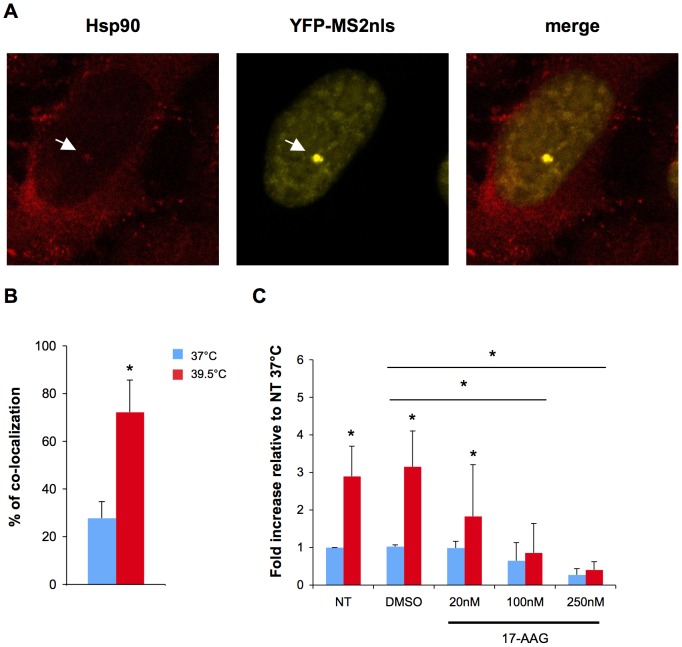
Role of Hsp90 during HIV-1 transcription and replication.A: Visualization of HIV transcription sites in U2OS HIVexo cells. One representative cell (at 37°C), displaying a co-localization of Hsp90 and nascent HIV RNA (followed with a YFP-MS2nls reporter protein) is shown. 2.5×105 U2OS HIVexo cells were plated on coverslips and grown overnight at 37°C. Cells were transfected with 50 ng of Tat and 300 ng of YFP-MS2nls. After 4 hours, cells were washed and grown overnight at 37°C or 39.5°C. B: Mean ± SD of 3 independent experiments. Cells showing a transcription spot were scored for their co-localization with Hsp90. The percentage corresponds to cells in which HIV transcription sites co-localize with Hsp90. Statistical significance was assessed by an unpaired t test p<0.05(*). C: effect of the Hsp90 inhibitor 17-AAG on single-cycle HIV infection in P4C5 cells. Mean ± SD of 4 independent experiments is shown. 2×105 P4C5 cells were infected with 30 ng Gag p24 of Δenv(VSV) for 2 hours at 37°C or 39.5°C, in presence of the indicated doses of 17-AAG. Cells were washed and grown at 37°C or 39.5°C at the indicated doses of 17-AAG. Cells were harvested 24 hours p.i. and Gag levels were assessed by flow cytometry. As a negative control, we used DMSO at a concentration corresponding to 250 nM 17-AAG.